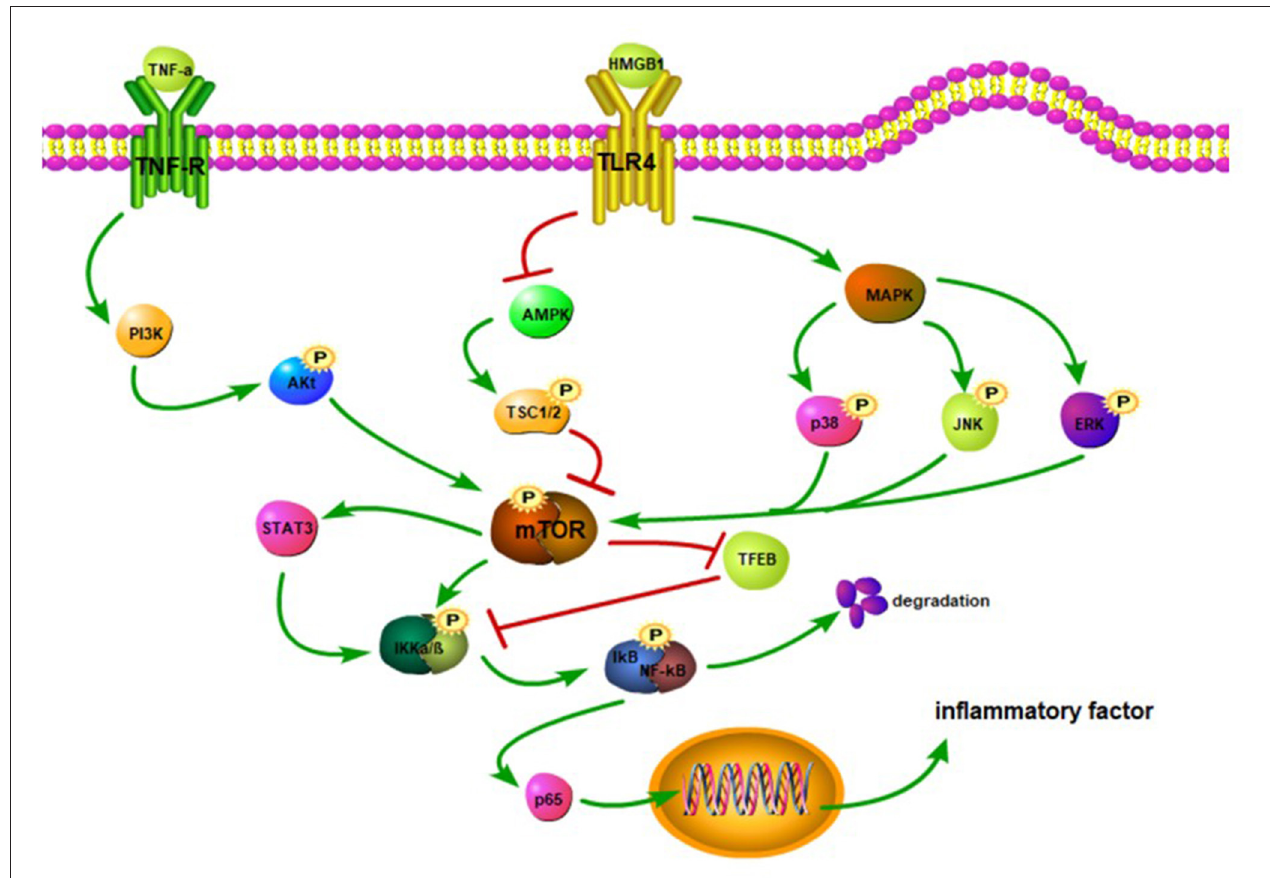
FIGURE 2 | TNF- α binds to its receptor, activates PI3K, and promotes Akt phosphorylation. The Akt activates the mTOR. The HMGB1 binds to the TLR4 to inhibit the activation of the AMPK and trigger MAPK. The inhibition of the AMPK reduces the phosphorylation of TSC1/2, thereby hindering the activation of the mTOR. The MAPK promotes the phosphorylation of JNK, p38, and ERK to activate the mTOR. The mTOR stimulates STAT3 and facilitates the phosphorylation of IKK α / β . The mTOR can suppress the TFEB activation, which in turn may inhibit the IKK α / β phosphorylation. The activation of the NF- κ B promotes the release of p65. When p65 is released into the cytoplasm, it translocates to the nucleus and upregulatesthe expression of inflammatory factors.